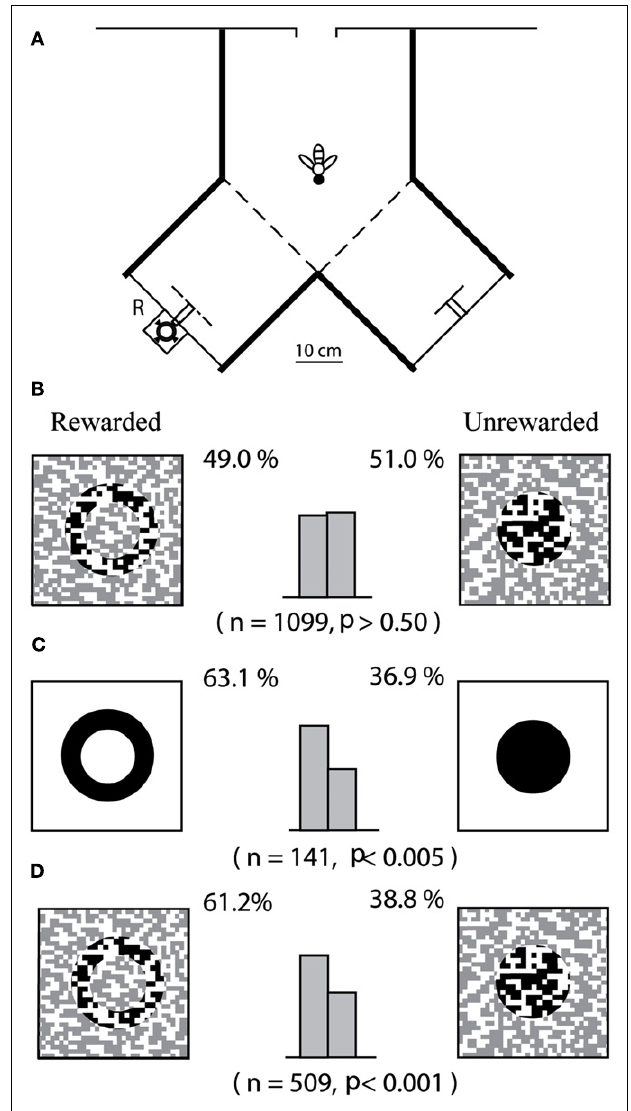
FIGURE 2 | Investigation of “top-down” processing in honeybees. Adapted from Zhang and Srinivasan (1994). (A) Experimental setup; (B) bees are trained and tested directly on camouflaged patterns; (C) bees are first trained on simple patterns; and (D) tested on camouflaged